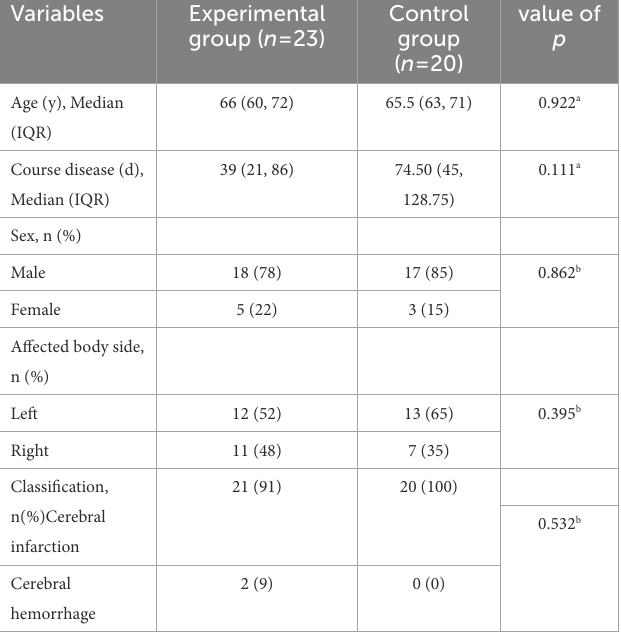
TABLE 1 Participant characteristics at baseline.